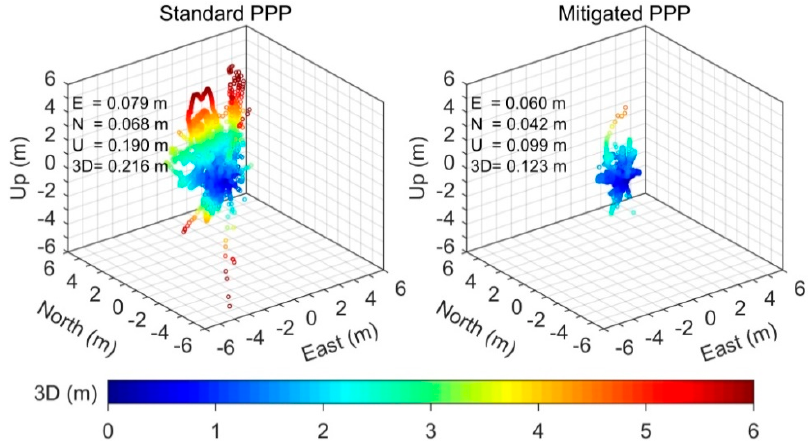
Figure 14. Distribution of positioning errors in the east, north, and up directions for the standard PPP and mitigated PPP using BDS satellites data collected by 10 GNSS stations from 1 September 2015 to 30 November 2015. The corresponding RMS values are shown in the upper left